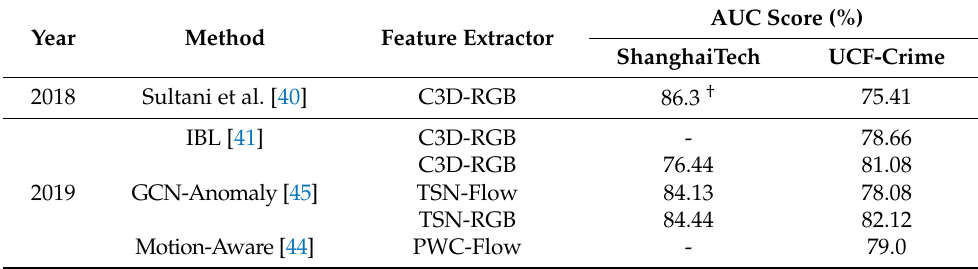
Table 2. Frame level AUC scores of several weakly supervised methods, benchmarked on ShangaiTech Campus [4] and UCF-Crime [40] datasets. Results compiled by Feng et al. [39]